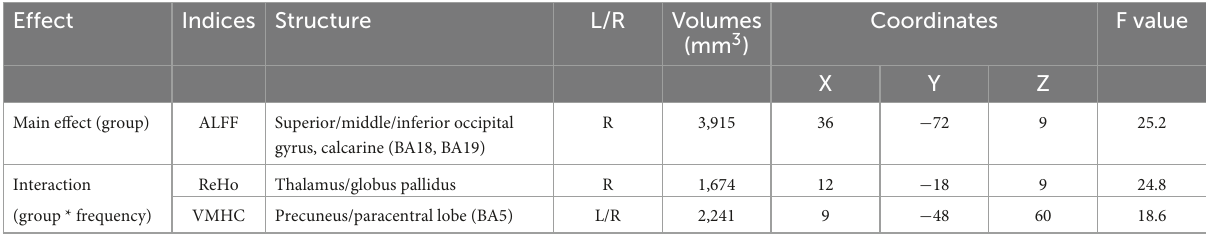
TABLE 3 Main effect of group and group * frequency interaction in PLWH compared with seronegative controls.